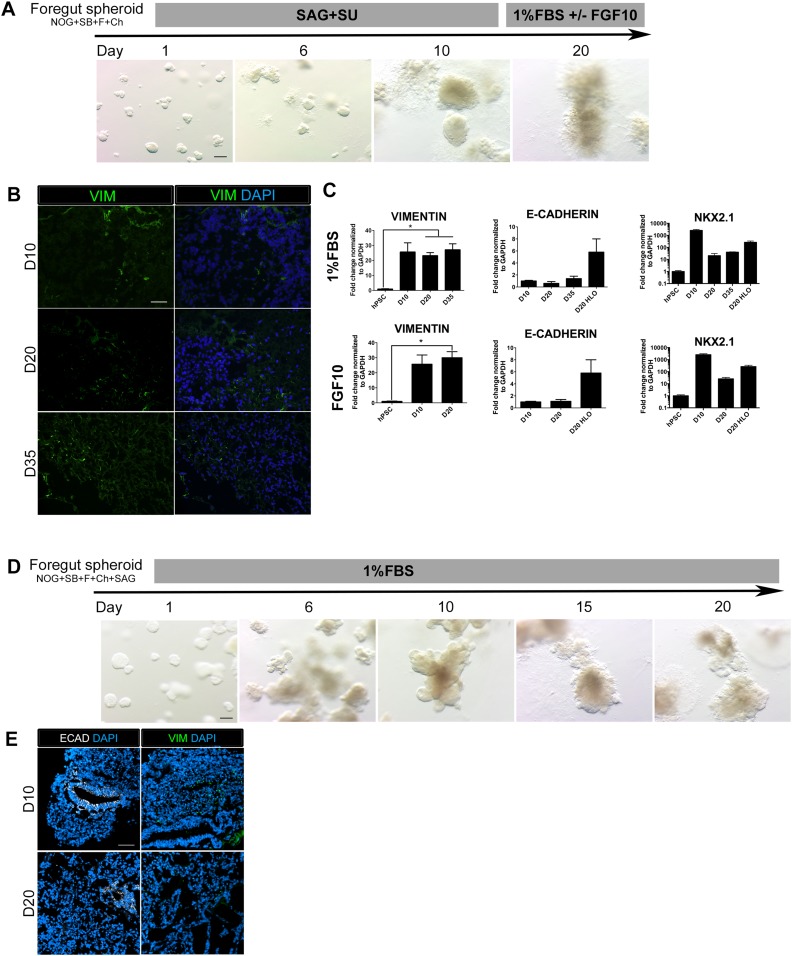
FGF-low culture conditions cause a loss of organoid epithelium over time.(A) NOG+SB+F+Ch foregut spheroids were generated and then cultured in SAG+SU for 10 days followed by 1% FBS ± FGF10. Timeline images show organoids cultured in 1% FBS. By day 20, 3D structures appeared ‘fuzzy’, which indicates an outgrowth of mesenchymal tissue. Scale bar represents 200 µm. (B) NOG+SB+F+Ch foregut spheroids treated with SAG+SU and maintained in 1% FBS showed an increase in Vimentin (VIM, green) immunofluorescence over time. Scale bar represents 50 µM. (C) NOG+SB+F+Ch foregut spheroids treated with SAG+SU and maintained in 1% FBS (upper panel) or 1% FBS+FGF10 (lower panel) had a significant increase of VIM expression starting at day 20 (D20) compared to hPSCs and showed very weak E-CADHERIN (CDH1) expression compared to D20 HLOS (optimized conditions, as described in Figure 3). Lastly, both conditions appeared to lose NKX2.1 expression over time. (D) NOG+SB+F+Ch+SAG spheroids maintained in 1% FBS (basal media) also appear to lose epithelial structures over time. Scale bar represents 200 µm. (E) By day 20 (D20) the tissue had very few epithelial structures expressing ECAD (white, left panel) and there was robust VIM expression (green, right panel) at both time points. Scale bar represents 50 µm. HLO *p < 0.05. All error bars represent SEM.